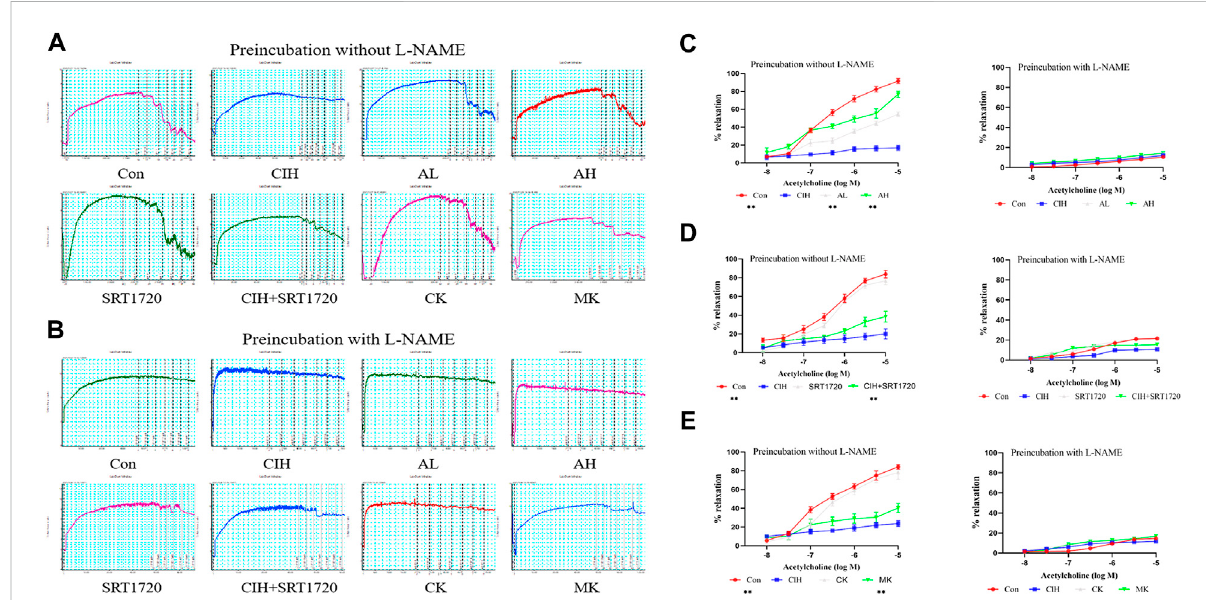
FIGURE 1 Effects of As-IV, Capn1 knockout and SRT1720 on VED in mice exposed to CIH. (A,B) The reactivity of PE-preconstricted aortic rings from all groups to ACh-mediated relaxation with or without L-NAME (C) The effect of As-IV treatment on ACh-induced vasodilation in aortas of CIH- exposed(90 sof21%O 2 and90 sof10%O 2 )mice( n =5). (D) TheeffectofSRT1720(4 µM)incubationonACh-inducedvasodilationinaortasofCIH- exposed mice( n = 5). (E) The effect ofCapn1 knockout treatment on ACh-induced vasodilationinaortasof CIH-exposed mice ( n =5). Data are presented as the means ± SD, ** p < 0.01, vs. CIH